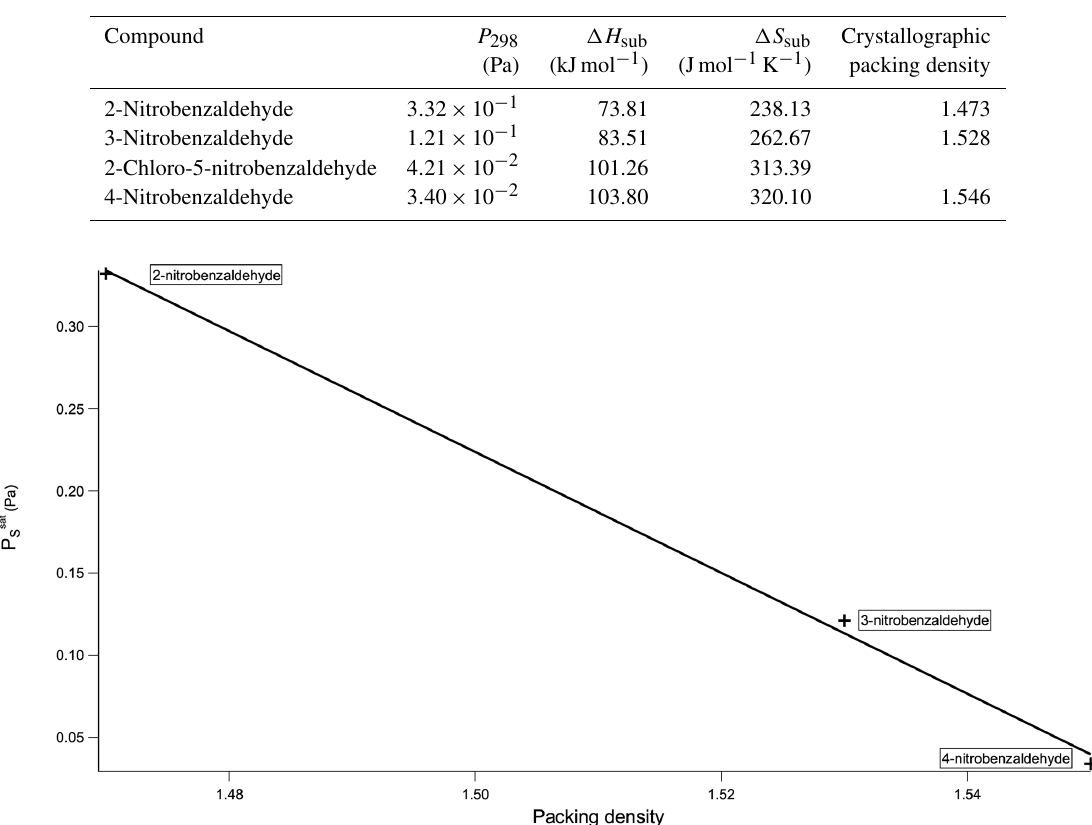
Figure 7. P sat vs. packing density of the nitrobenzaldehydes. S